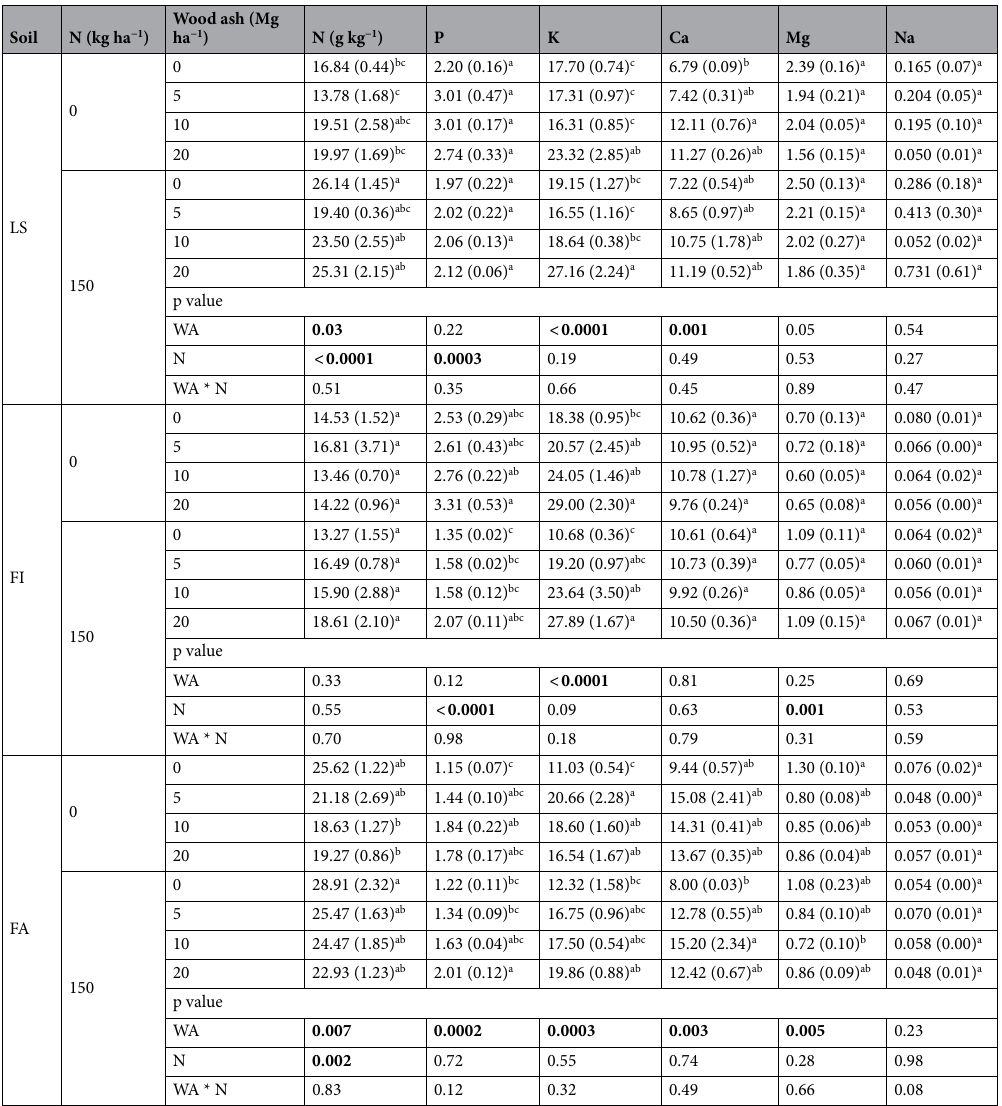
Table 3. Foliage nutrient concentrations of seedlings applied with four levels of wood ash (WA; 0, 50, 10, and 20 Mg ha −1 ) and two levels of N fertilizer (N fert; 0 and 150 kg ha −1 ) across three different soil types (LS, landfill saline soil; FI, forest infertile soil; FA, forest acidic soil) at the end of this study (20 weeks after treatment). Standard errors are shown in parentheses (n = 3). P values are from the result of two-way ANOVA to detect the effect of wood ash and N fertilizer on each soil property within each soil type. Significant p values are in bold. Different lower case letters within each soil indicate significant differences (p < 0.05, Tukey–Kramer comparison lines for least squares means) for each nutrient concentration across four wood ash levels and N fertilizer